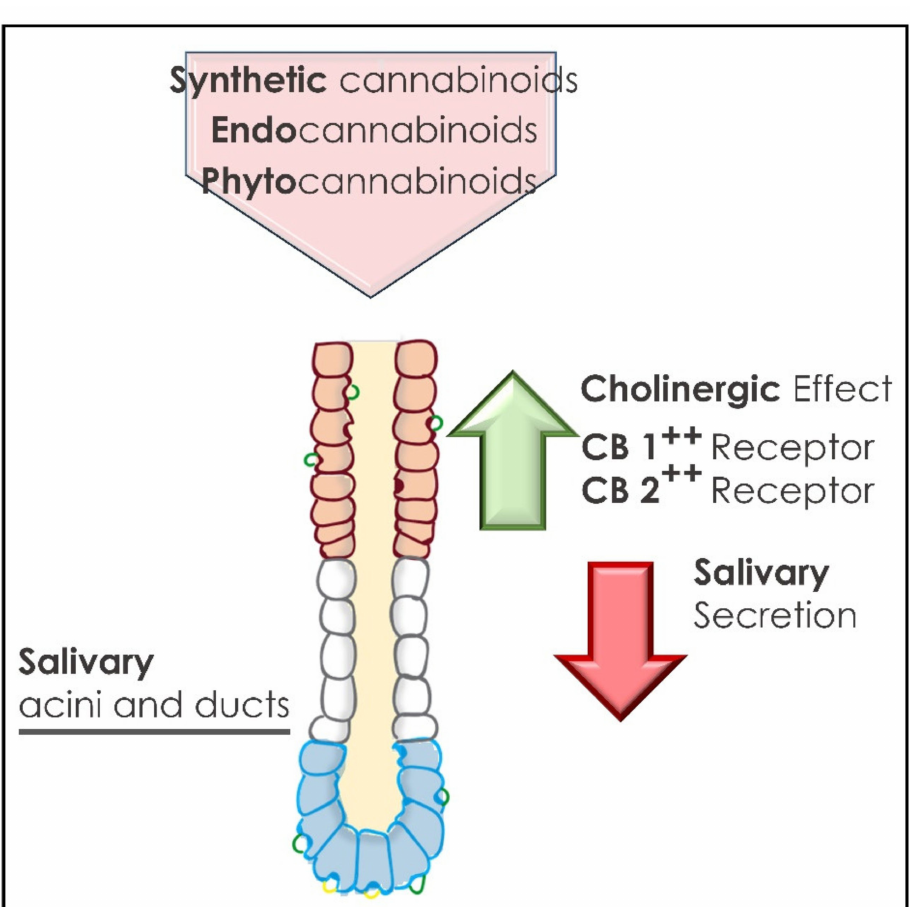
Figure 3. Salivary glands’ acini and ducts activity associated with cannabinoid